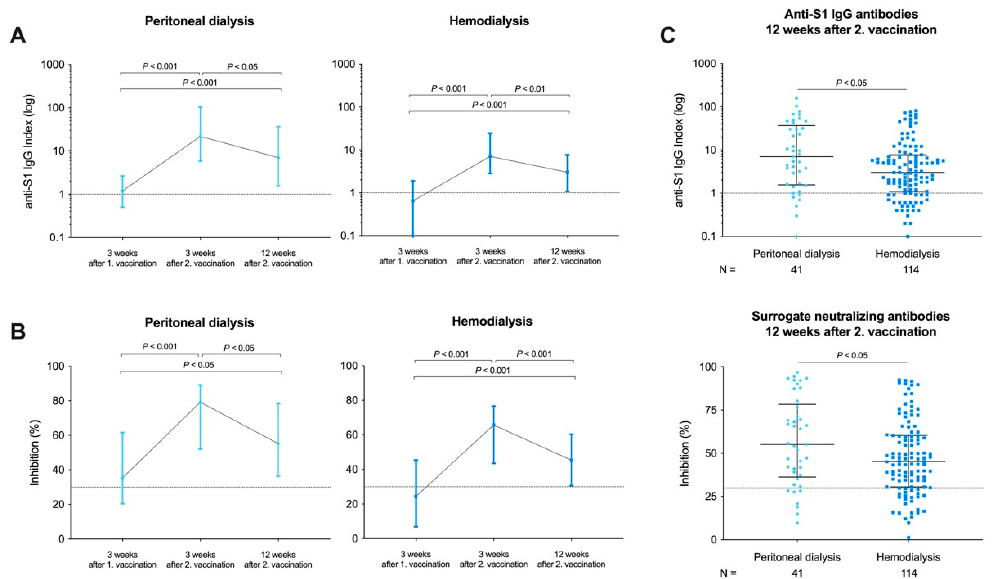
Figure 3. Patient-paired analysis of SARS-CoV-2 anti-S1 IgG and surrogate neutralizing antibodies (SNA) three weeks after prime, three weeks after boost, and twelve weeks after boost immunization with BNT162b2 in patients receiving peritoneal dialysis or hemodialysis treatment. Anti-S1 IgG antibodies are represented logarithmically in a patient-paired analysis for peritoneal dialysis and hemodialysis patients ( A ). Anti-S1 IgG values are given as a median with an interquartile range. The dashed black line represents the cut-off for detection with a semi-quantitative index ≥ 1 defining positivity. SARS-CoV-2 SNA is presented as percent (%) inhibition in a patient-paired analysis for peritoneal dialysis and hemodialysis patients ( B ). Anti-S1 IgG antibodies and SARS-CoV-2 SNA twelve weeks after second vaccination in peritoneal dialysis and hemodialysis patients. SNA values are given as a median with interquartile range. The dashed black line represents the cut-off of ≥ 30% in this assay according to the manufacturer’s instructions ( C ).